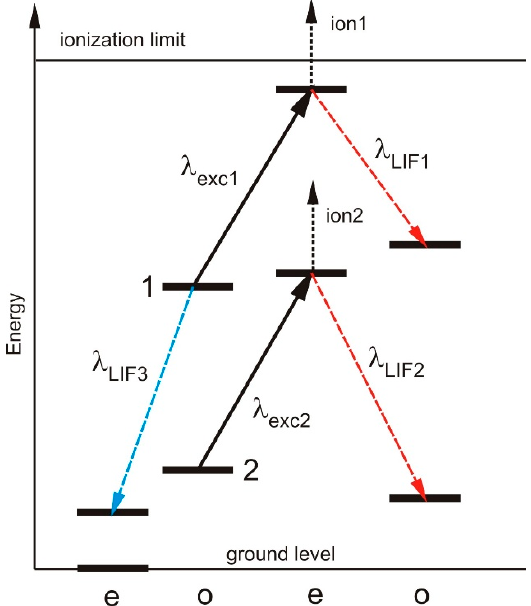
Figure 1. LIF signals which can be observed due to laser excitation. It is assumed that the excitation wavelengths 1 and 2 are closely neighbored, thus, a blend situation is observed with not state-selective detection (e.g., OG spectroscopy). When detecting positive LIF lines (shown in red), the upper level can be identified and—due to the different LIF wavelengths 1 and 2, the blend lines can be separated. The lower level of excitation 1 can be identified also by detecting LIF-line 3. Since the population of state 1 is lowered by laser excitation, the LIF signal 3 has opposite phase (“negative” LIF) compared to LIF-signals 1 and 2. If the upper level of transition 1 is close to the ionization limit, its ionization probability may be large, leading to a good OG signal but a decrease of the intensity of LIF-line 1, in some cases not distinguishable from noise. This situation is usually true for even La-levels with energies larger than 41,000 cm − 1 (limit 44,981 cm − 1 [3]). The observed linewidth is influenced by